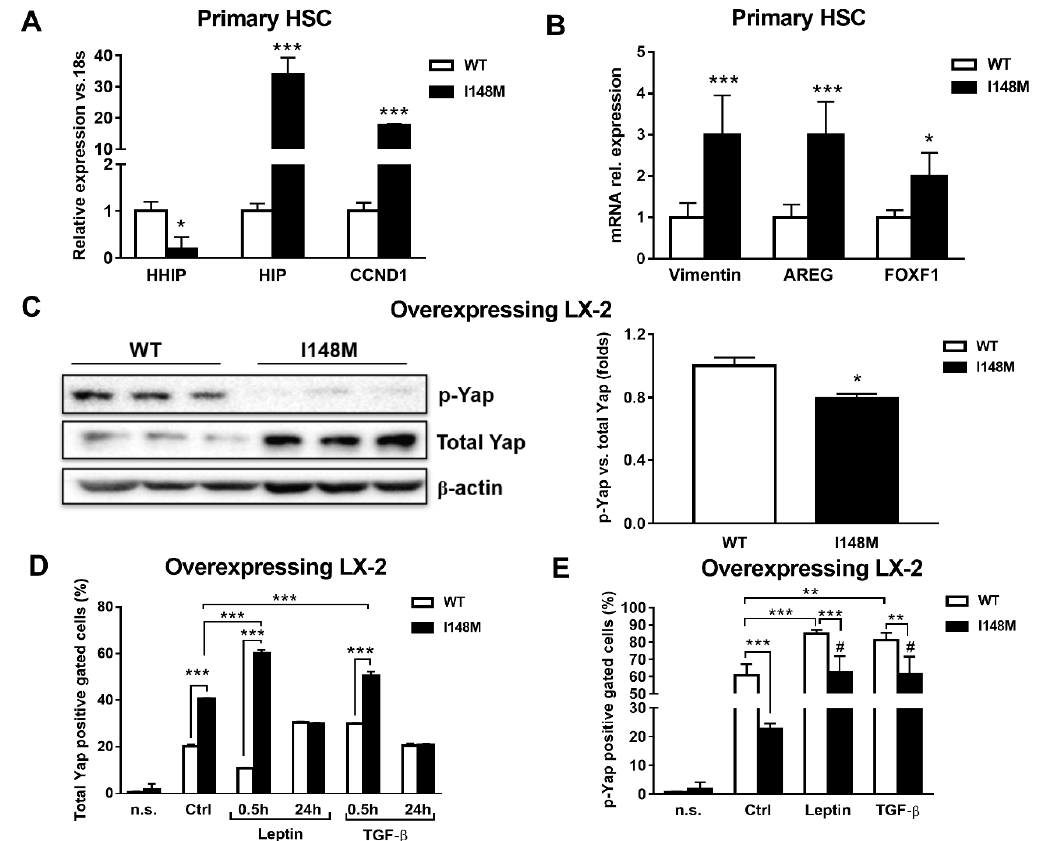
Figure 3. Up-regulated Hedgehog targets result in activation of Yap in HSCs carrying I148M PNPLA3 . Primary HSCs and LX-2 stably overexpressing cells ( n = 3 each PNPLA3 genotype) were cultivated in